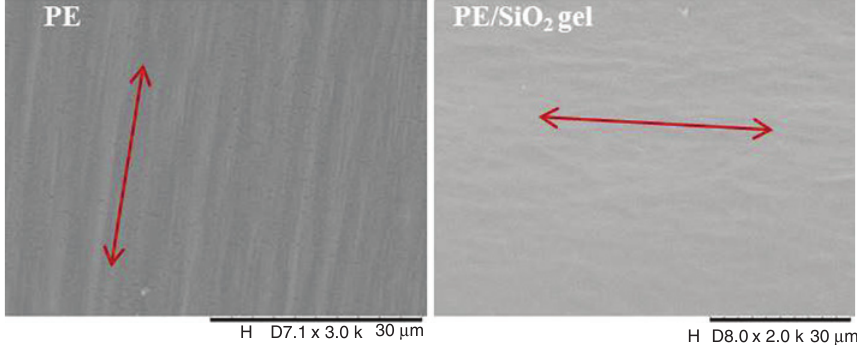
gel composites under stretching at 120 ° C. 2